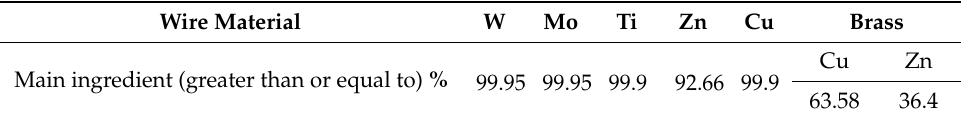
Table 1. The main ingredients of wire materials used in this work. Wire Material W Mo Ti Zn Cu Brass Main ingredient (greater than or equal to)